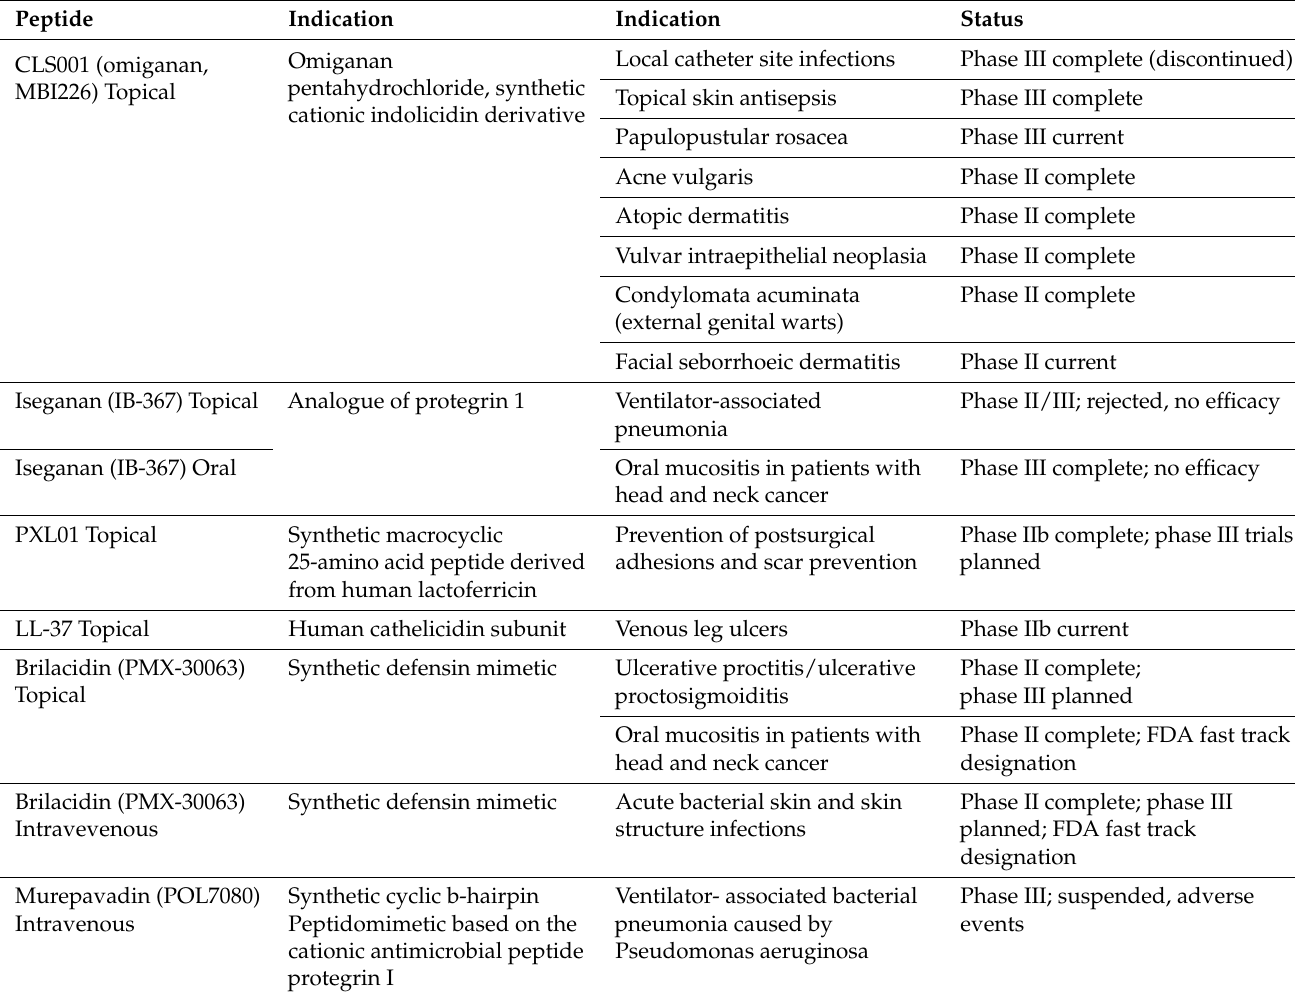
Table 2. Selected AMPs for regenerative applications that are in clinical trials or approved, to